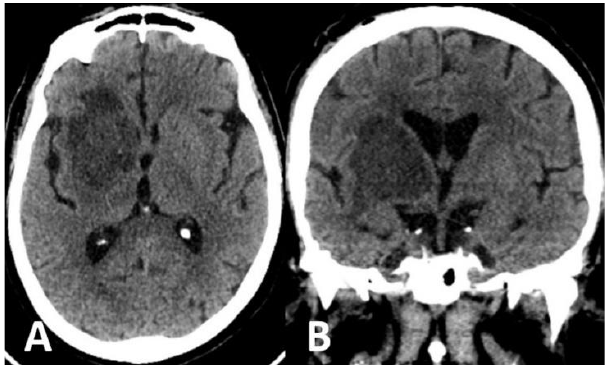
Figure 1. CT scan of the brain ( A , B ) showed a space-occupying hypodense lesion in the right basal ganglia, surrounded by edema involving the frontal and temporal lobes. Mass effect was seen with effacement of cerebral sulci, compression of the ventricular system and mild left deviation of midline structures.